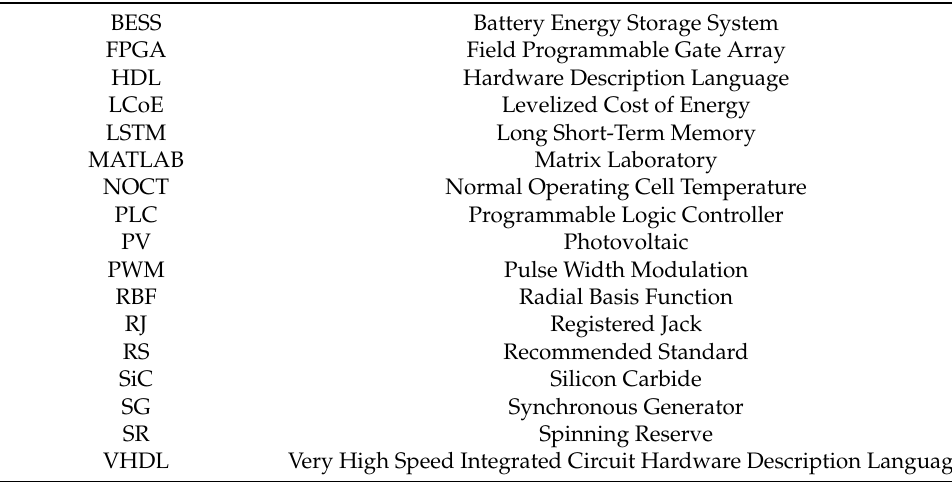
Table A1. The following abbreviations are used in this